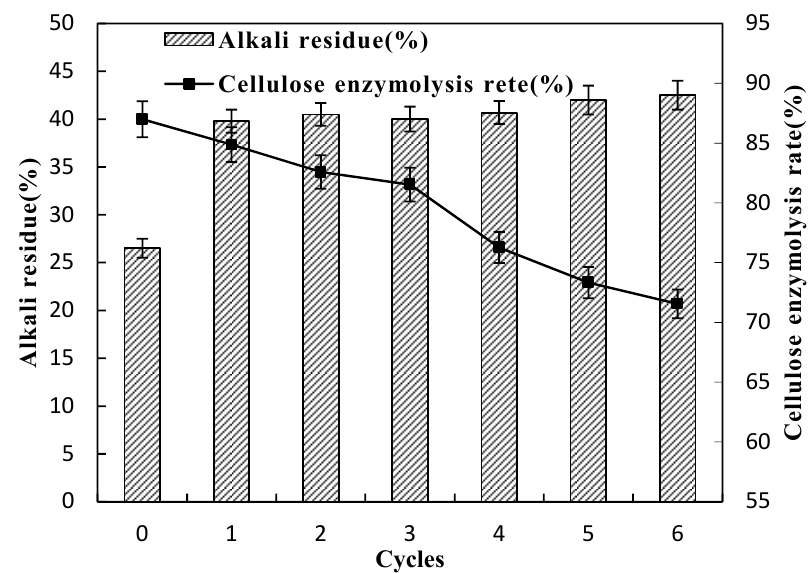
Figure 3. Effect of different times of alkaline black liquor circulation on alkali residue in solution and enzymatic hydrolysis rate.